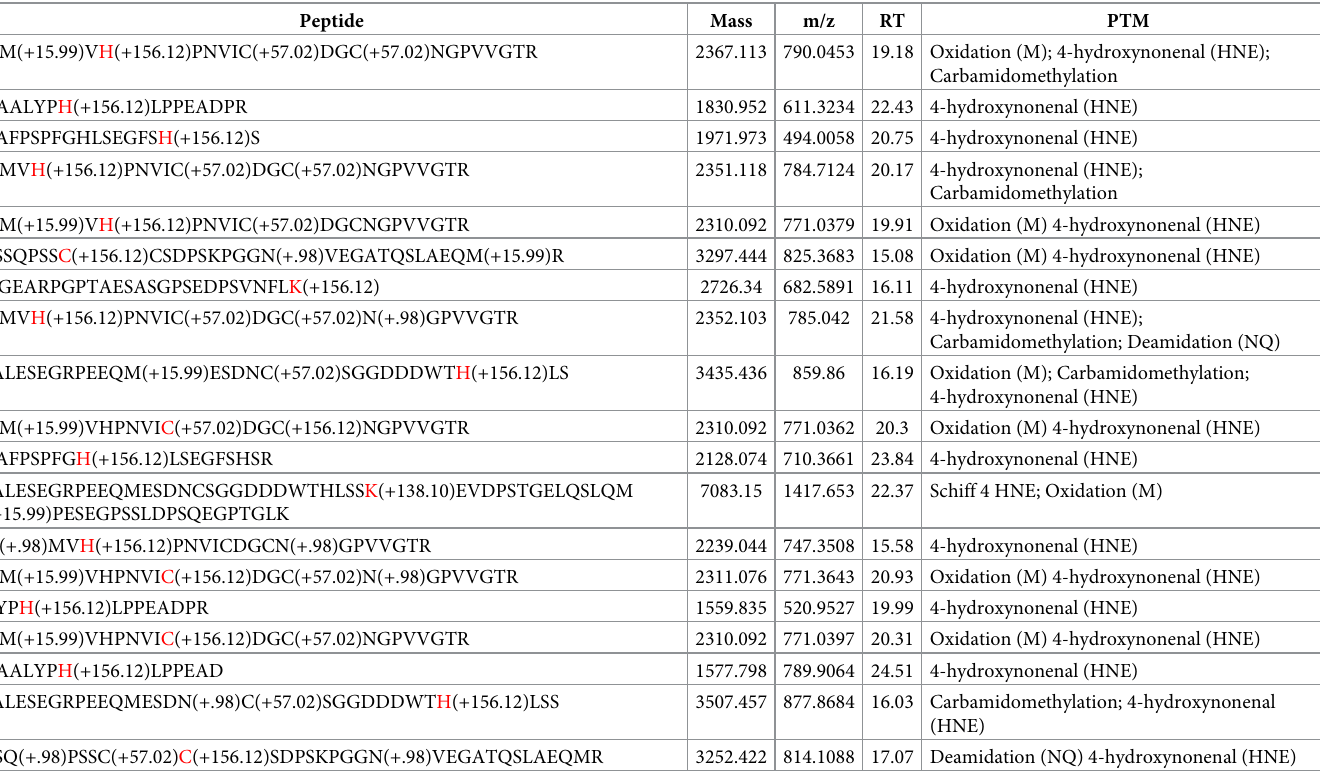
Table 2. 4-HNE modified peptides identified from tryptic digests of 4-HNE-treated recombinant